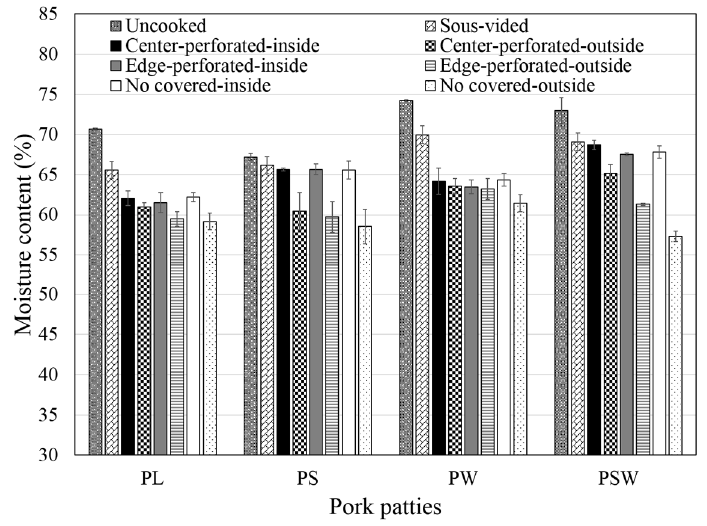
Figure 7. Moisture contents of pork patties before and after microwave